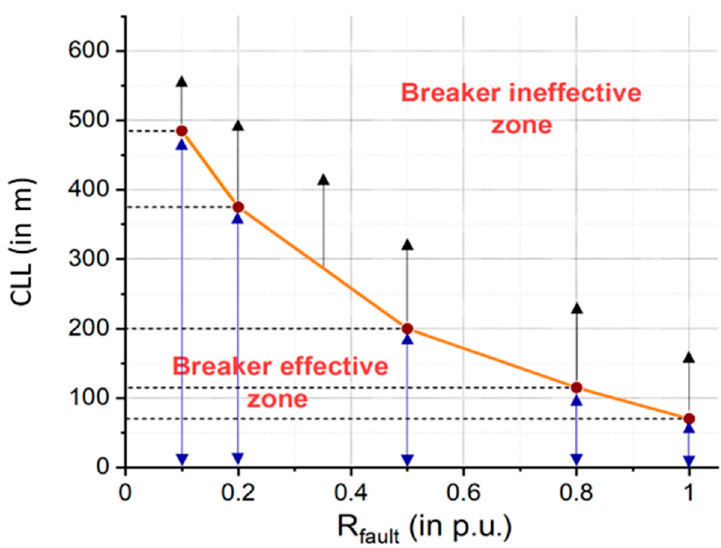
Figure 3. Summary of cable length limit related to fault current levels.